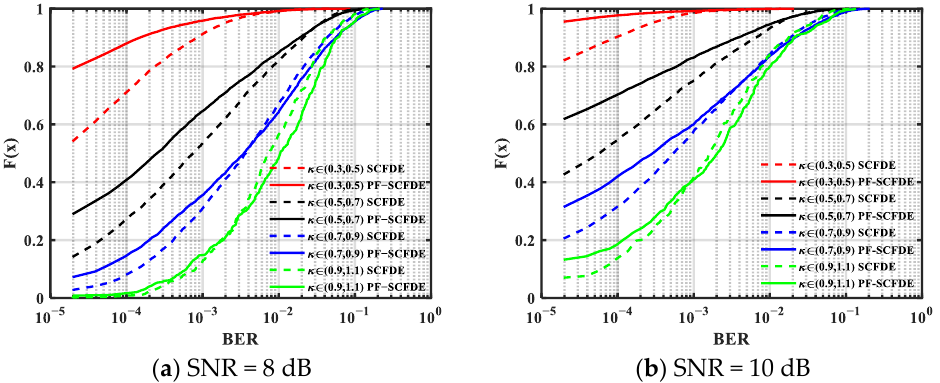
Figure 4. BER cumulative distribution function for MSK.